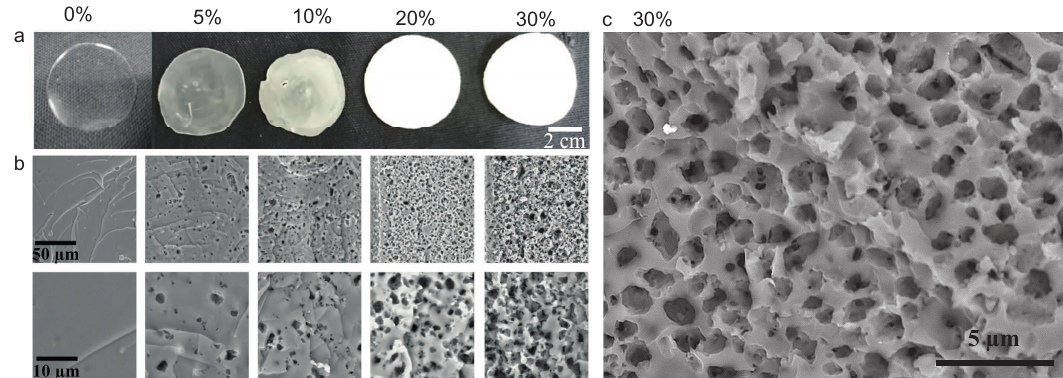
Figure 4. ( a ) monoliths prepared with volume fractions of calcite between 0 and 0.3, observed here after photo-polymerization, calcite removal by acidic dissolution, and drying; ( b ) SEM views of cut